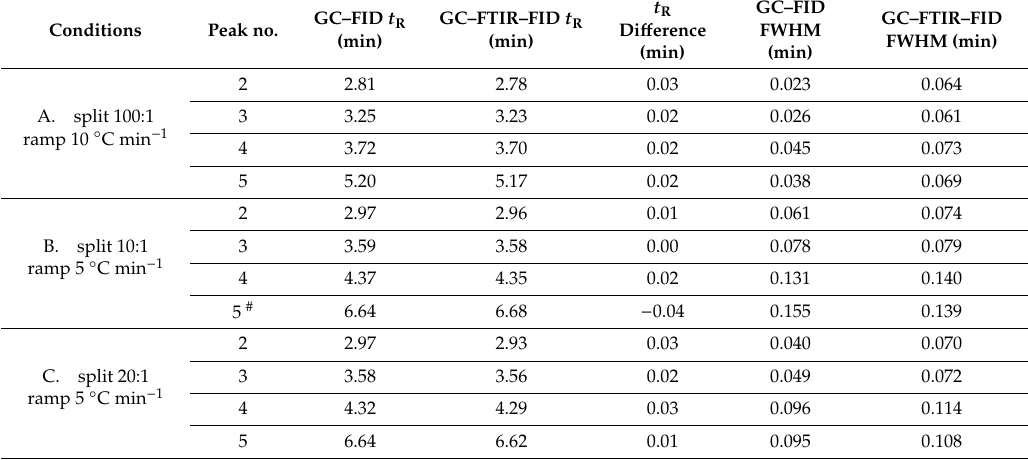
Table 1. Comparison of GC chromatographic FID peaks between direct FID and post-light-pipe FID results at various split ratio and temperature ramp combinations. Retention times and full width half maximum (FWHM) values are presented for peaks 2 to 5 depicted in Figure 1. Peaks 2, 3, 4 and 5 correspond to the compounds 2-butanol, 2-pentanone, 1-nitropropane and m -xylene respectively. Conditions Peak